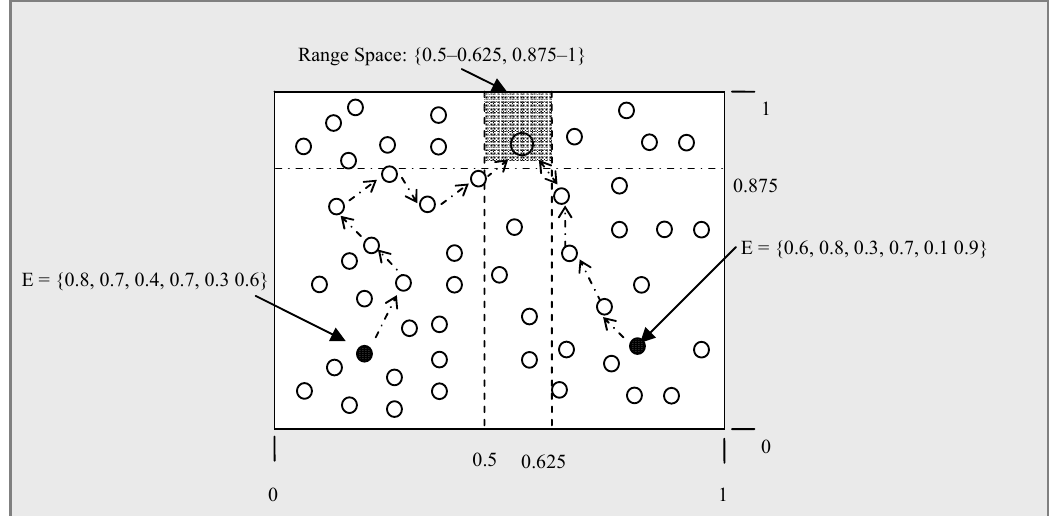
Figure 5. Multidimensional Range Query Mechanism (MDAs)